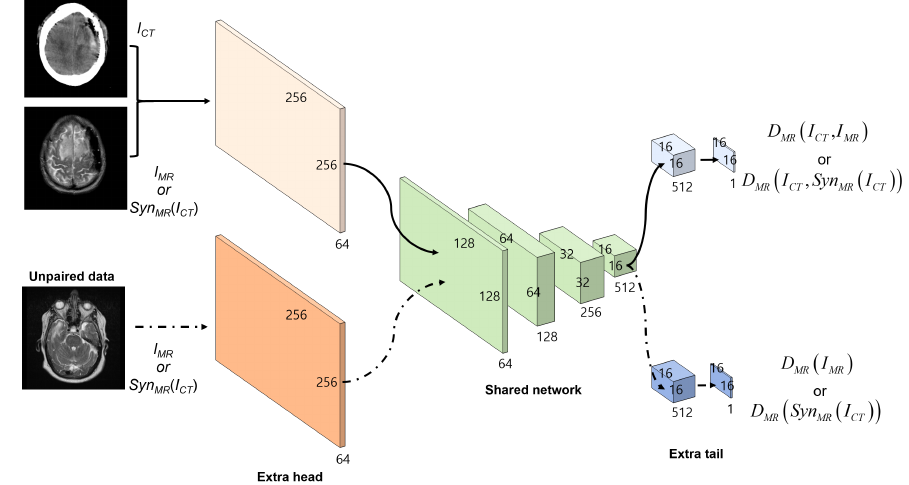
Figure 4. Flow diagram of the discriminator Dis MR in the synthesis system. Dis MR has extra head and extra tail convolutional layers for the different input and loss functions of the paired and unpaired data. Discriminator Dis CT has the same architecture as the Dis MR